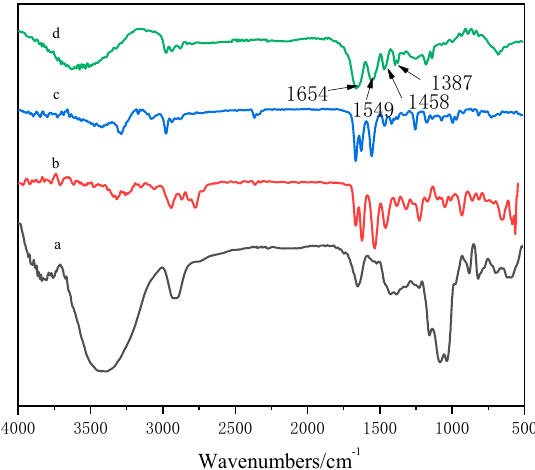
Figure 2. FTIR spectra of GA–P(NIPAM-co-DMAPMA) hydrogels. ( a ) GA; ( b ) DMAPMA; ( c ) NIPAM; ( d ) GA–P(NIPAM-co-DMAPMA) hydrogel.